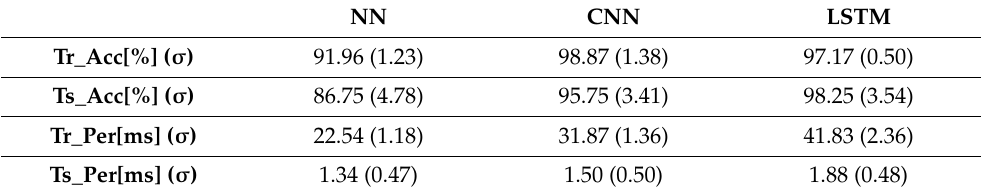
Table 3. Comparison of training and test results by type of artificial intelligence algorithm. NN CNN